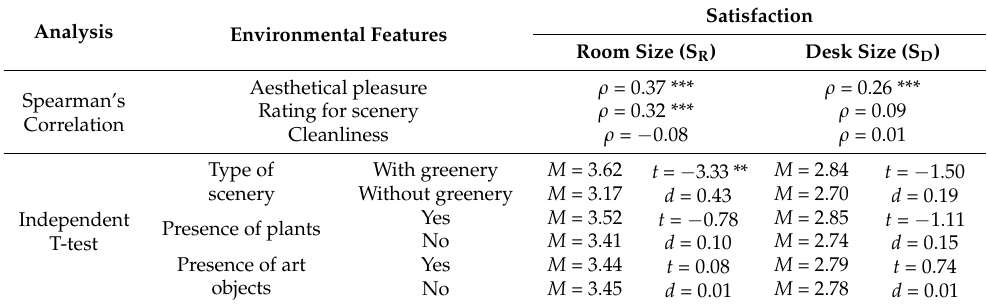
Table 7. Relationships between visual distractions and satisfaction with home workspace